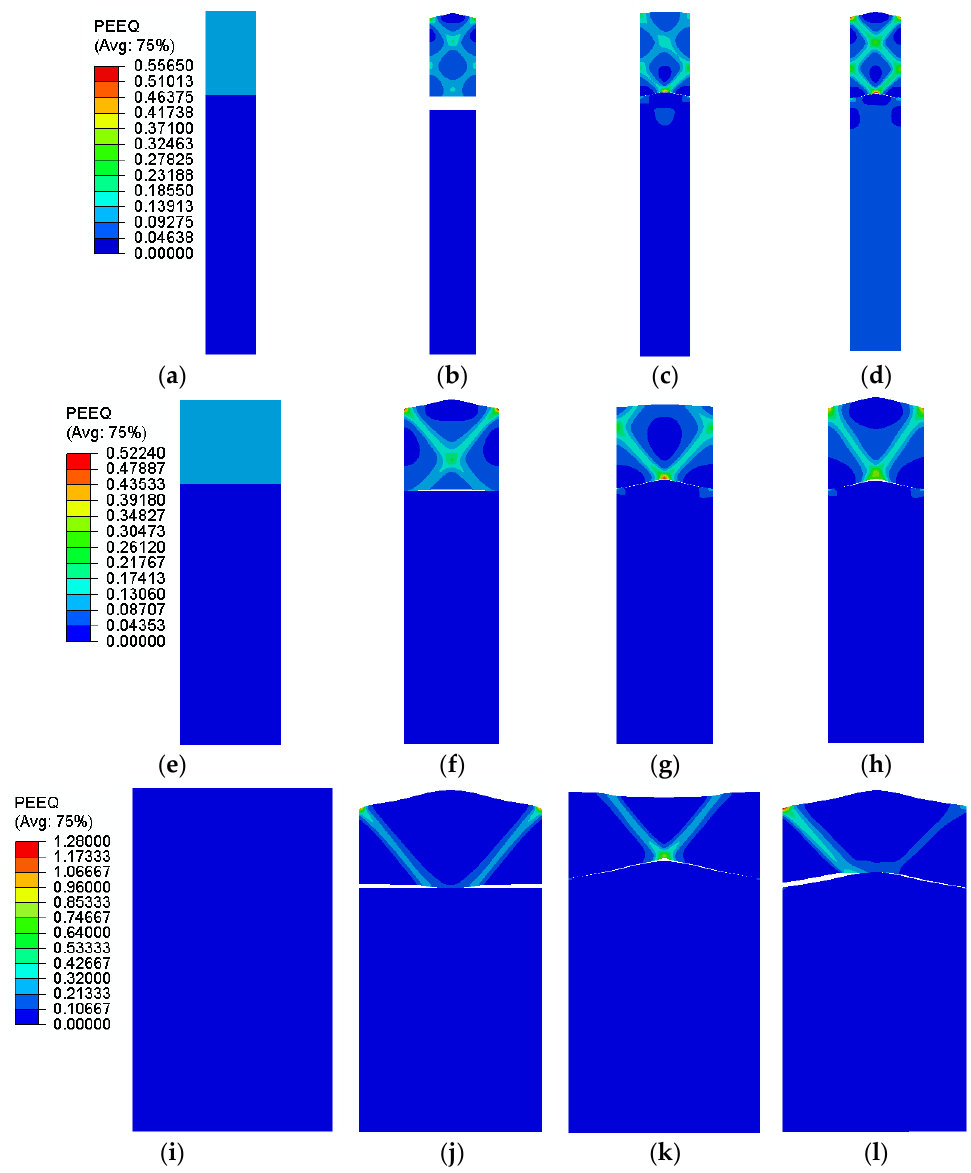
Figure 7. Distribution of equivalent plastic strain at maximum stress for the laminate with a wave- length of ( a – d ) h/2, ( e – h ) h, ( i – l ) 2 h and ( a , e , i ) without roughness, ( b , f , j ) with wavy Al surface, ( c , g , k ) with wavy LDPE surface and ( d , h , l ) with both Al foil and LDPE wavy surfaces.